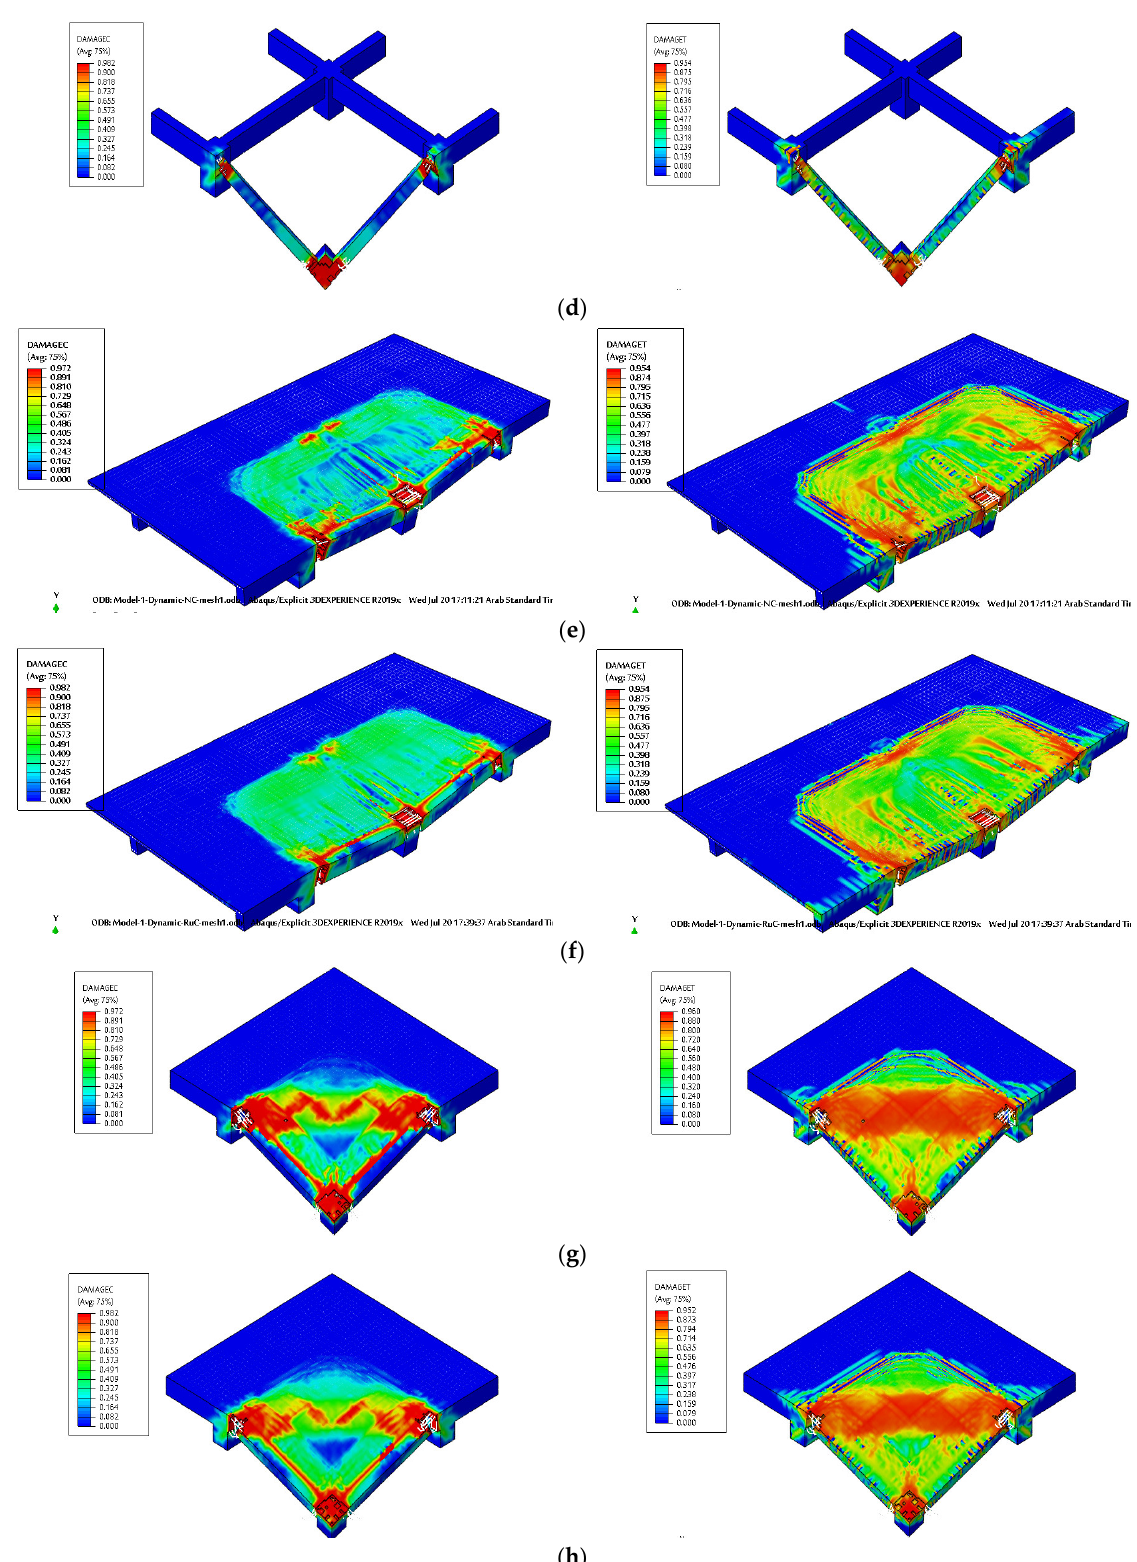
Figure 21. Concrete damages for all specimens: ( a ) NC-MID; ( b ) RuC-MID; ( c ) NC-COR; ( d ) RuC- COR; ( e ) NC-MID-Slab; ( f ) RuC-MID-Slab; ( g ) NC-COR-Slab; and ( h ) RuC-COR-Slab.